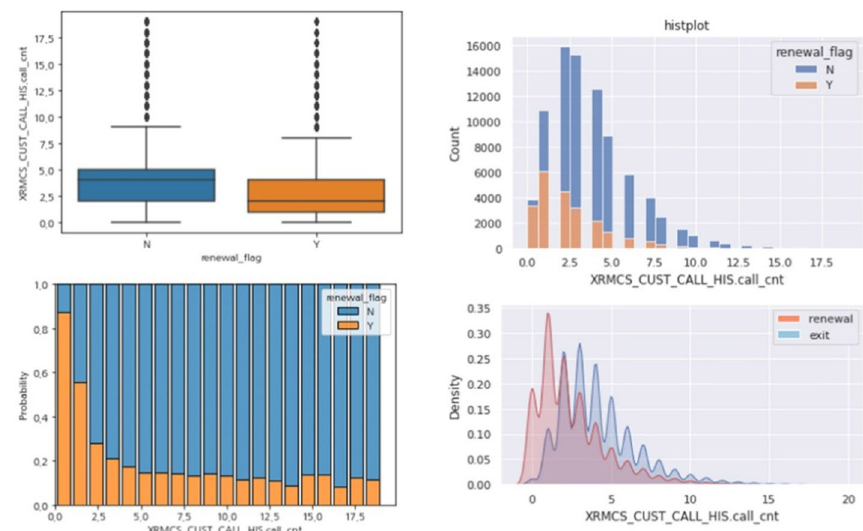
Fig. 11 Results of comparative analysis by renewal (Y/N)—Inbound call